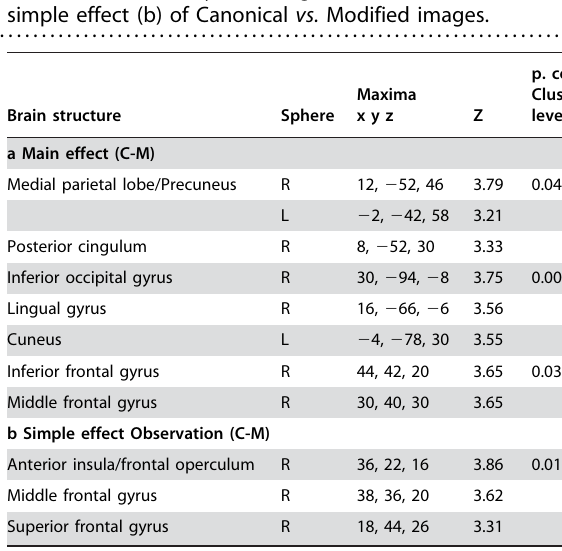
Table 2. Brain activity reflecting the main effect (a) and